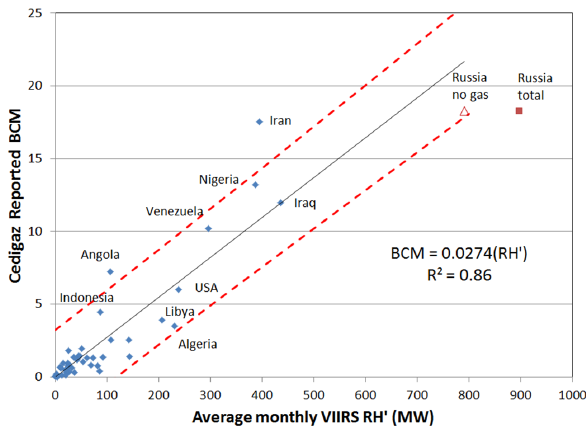
Figure 7. Calibration for estimating flared gas volumes from VIIRS ‐ derived RH based on Cedigaz reported data. The dashed red lines indicate the positions of the 95% confidence intervals for the billion cubic meter (BCM) prediction errors. Note that the Russian data used in the regression was filtered to remove flares in natural gas and gas condensate fields, since the flaring in these areas is not represented in the Cedigaz gas flaring estimates.